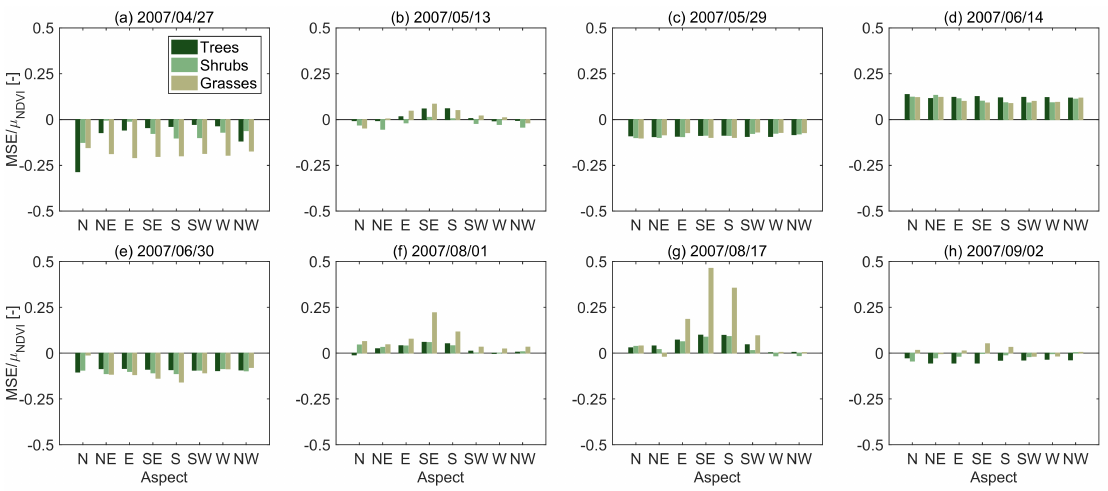
Figure 8. Normalized mean signed error ( MSE / µ NDVI ) separated by dominant vegetation functional type and aspect over the 2007 growing season at Dry Creek Experimental Watershed (DCEW), Idaho, USA for ( a ) 27 April 2007, ( b ) 13 May 2007, ( c ) 29 May 2007, ( d ) 14 June 2007, ( e ) 30 June 2007, ( f ) 1 August 2007, ( g ) 17 August 2007, and ( h ) 2 September 2007. Errors were normalized by dividing MSE by the mean normalized difference vegetation index (NDVI) for the given vegetation functional type on the given date (see Table